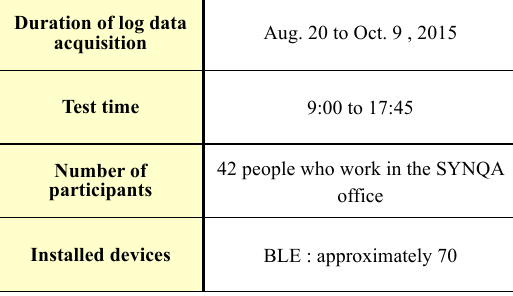
Table 1. Overview of the field